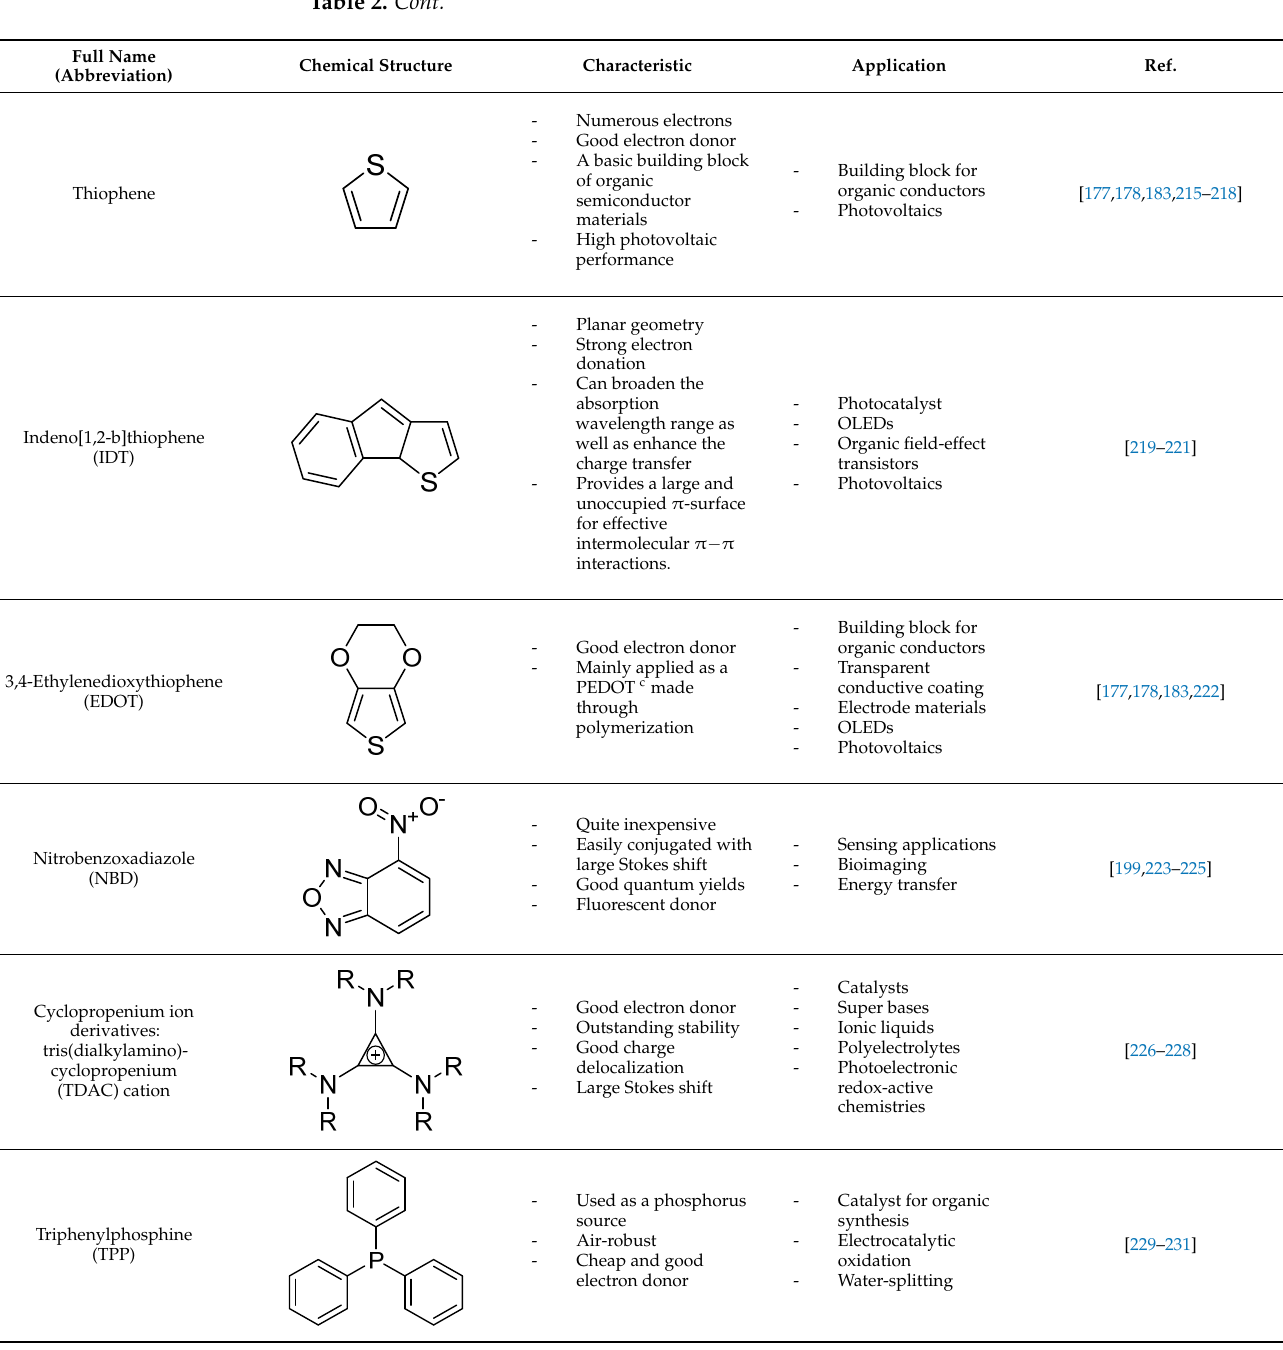
Table 4. Summary of the chemical units of polymer-based photoluminescence probes a .